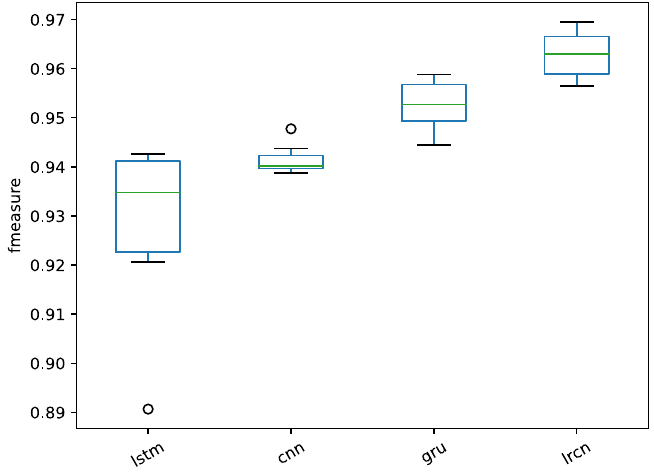
Figure 21. Comparison of the three baseline methods under the same conditions on the RWC